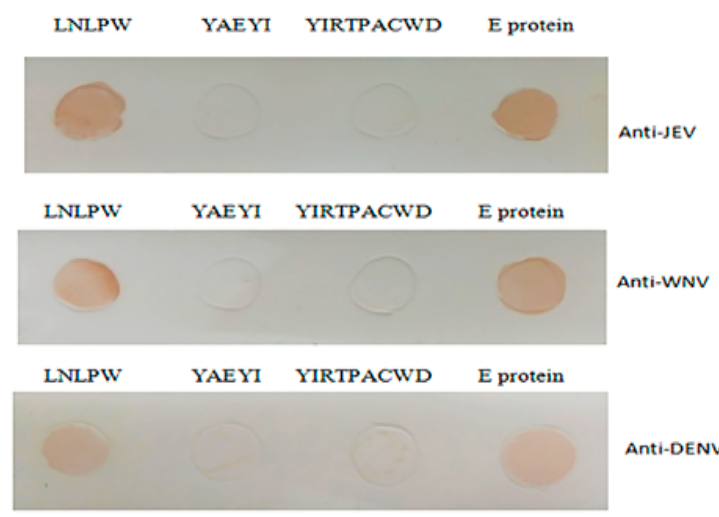
Figure 6. The cross-reactivity of the epitopes to the Japanese encephalitis virus (JEV)-, West Nile virus (WNV)-, and dengue virus (DENV)-positive sera in the dot blotting assay. YIRTPACWD and the E protein were used as the negative and positive controls, respectively.